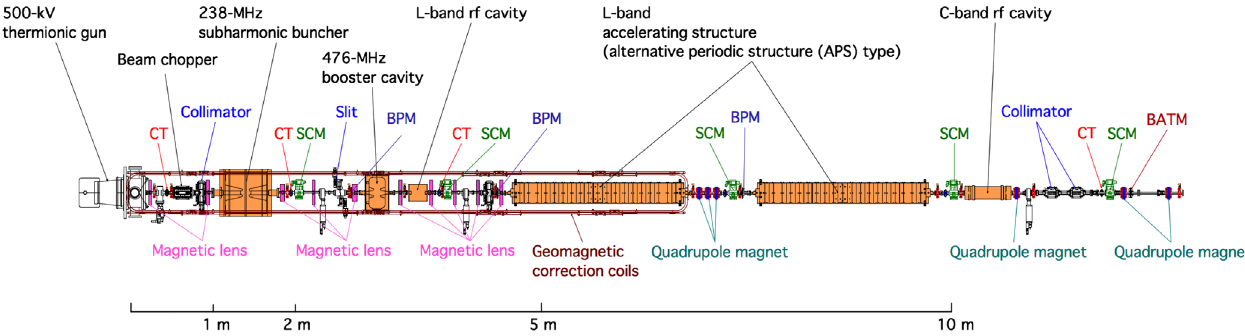
FIG. 2. Layout of the SACLA 30-MeV injector. The injector is equipped with various beam monitors: a current-transformer-type beam charge monitor (CT), a screen monitor (SCM), a strip-line-type beam position monitor (BPM), and a beam arrival time